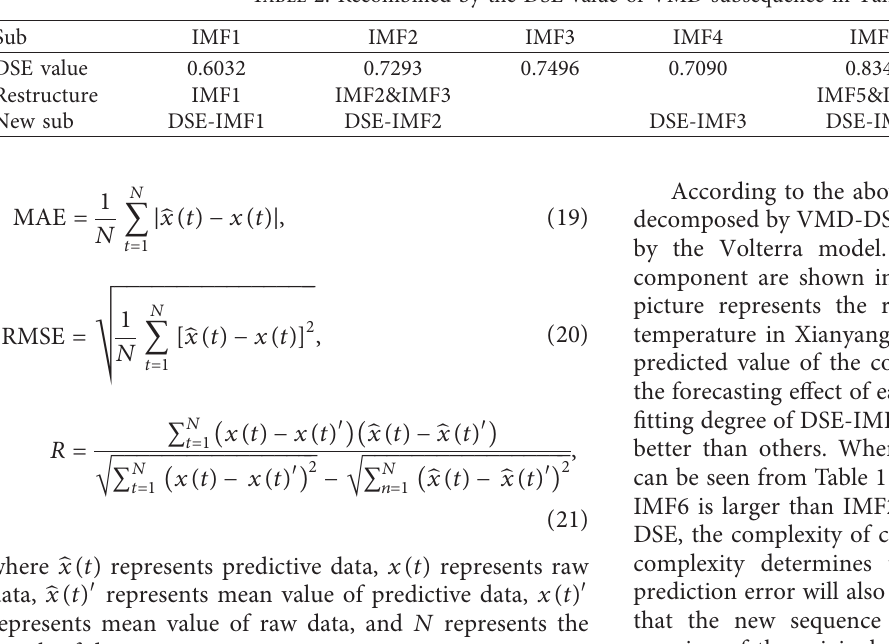
Figure 7: (a) VMD-DSE processing results of Xianyang temperature time series and (b) VMD-DSE processing results of Yan’an tem- perature time series. Table 2: Recombined by the DSE value of VMD subsequence in Yan’an